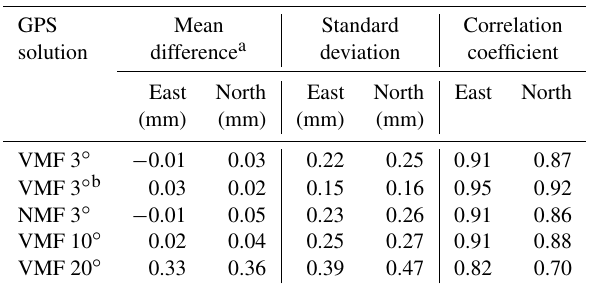
Table 8. Assessment of the different GPS solutions comparing total gradients from the two GPS stations ONSA and ONS1.